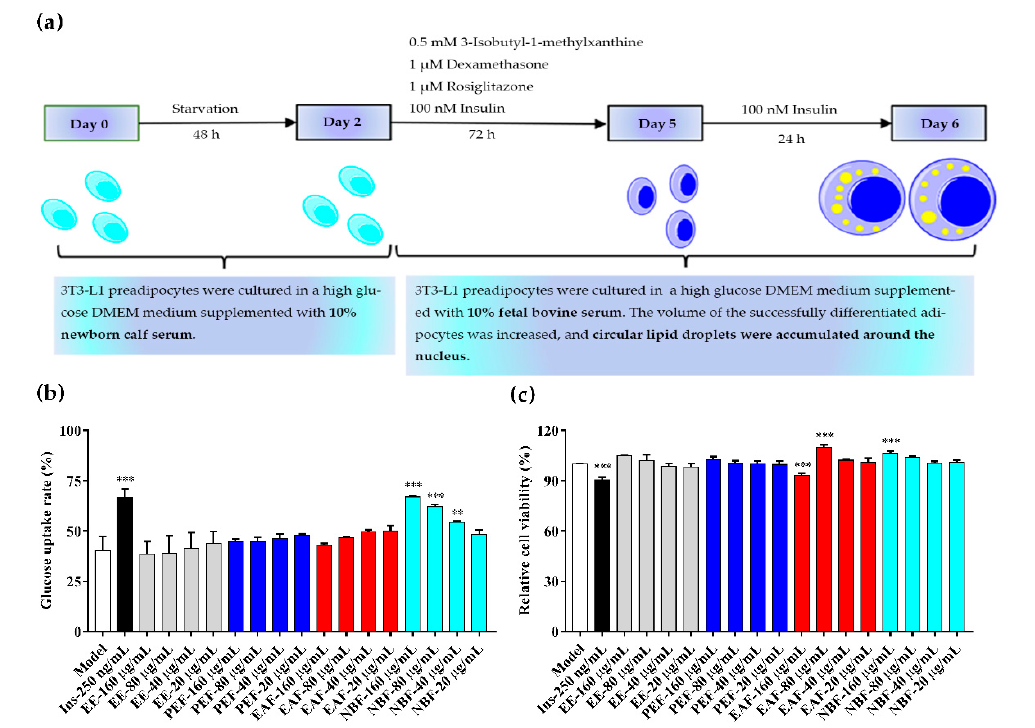
Figure 3. Adipocyte differentiation process and glucose uptake, cell viability test results of PAHEE and its fractions. ( a ) Schematic diagram of 3T3-L1 adipocytes differentiation. ( b ) Glucose uptake rate of different groups (Model, Ins, PAHEE, PEF, EAF, NBF), insulin (Ins) was used as a positive control. ( c ) Cell viability of different groups (Model, Ins, PAHEE, PEF, EAF, NBF). All values are mean ± SD from a least three independent experiments, and each group is compared with model group, Significant are denoted by symbols: ** p < 0.01, and *** p < 0.001.